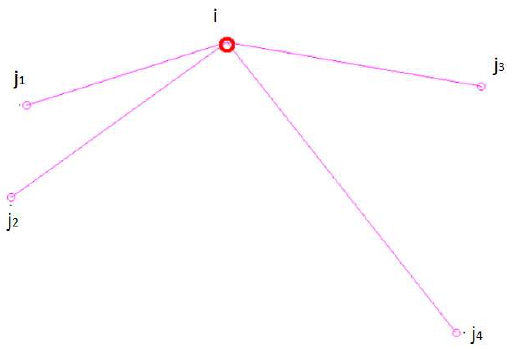
Figure 4. RBE2 element example: 1 Independent node and 4 dependent nodes.